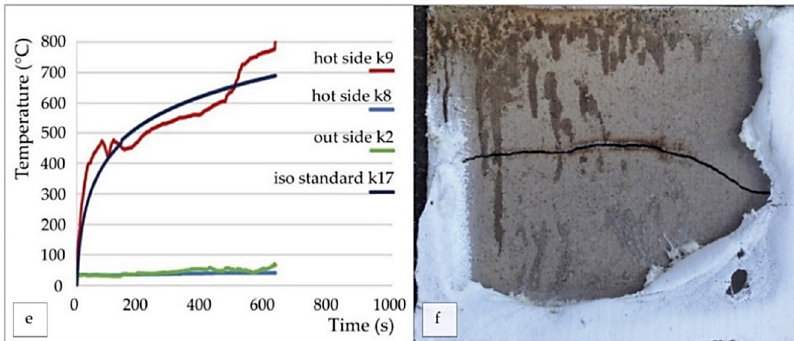
Figure 9. Fire resistance curves ( a , c , e ) and the outer surface of S20 (20, 15, 10 mm thick) after testing ( b , d , f ); K5, K9 and K1, K8 are the inner and outer thermocouples; K17 is the standard